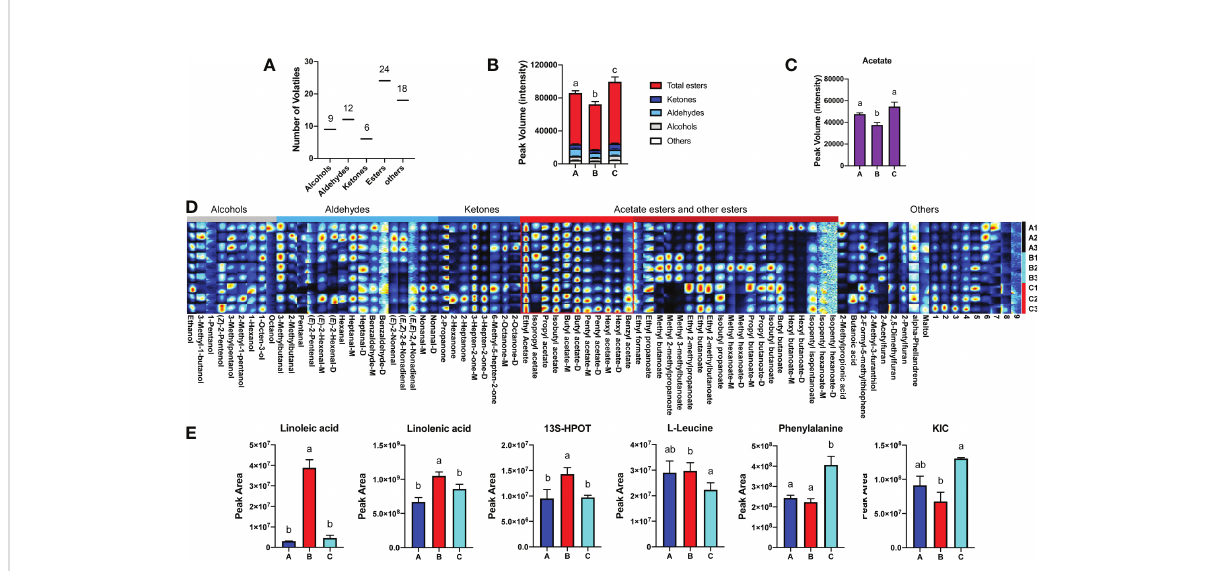
FIGURE 2 Changes of melon volatile content and metabolites in response to chilling. (A) Classi fi cation and numbers of all volatiles detected. (B) Statistical analysis of changes in VOC content after chilling ( ± SE, n = 3). (C) Chilling-induced changes in total VAE content ( ± SE, n = 3). (D) Fingerprint of all volatiles detected in three groups. Each row represents all signal peaks in each sample, and each column represents the signal peak of the same VOC in different samples. The intensity of the ion signal is described by different colors, red indicates high intensity. VOC names are listed below each column, and some volatiles are followed by M and D, which are the monomer and dimer of the same volatile. The numbers indicate unidenti fi ed VOC peaks. Information of all volatiles is listed in Supplementary Table S1. (E) Statistical analysis of metabolites in fatty acid and amino acid pathways after chilling ( ± SE, n = 6). Signi fi cant differences in volatiles and metabolites are denoted by different letters ( p -value < 0.05). HPOT, Hydroperoxy octadecatrienoic acid; KIC, Ketoisocaprorate. Group A, stored at 4°C for 7 d, and then transferred to room temperature (~22°C) for 1 d; Group B, held at 4°C for 8 d; Group C, melon fruit were harvested 8 d after the fruit of fi rst two